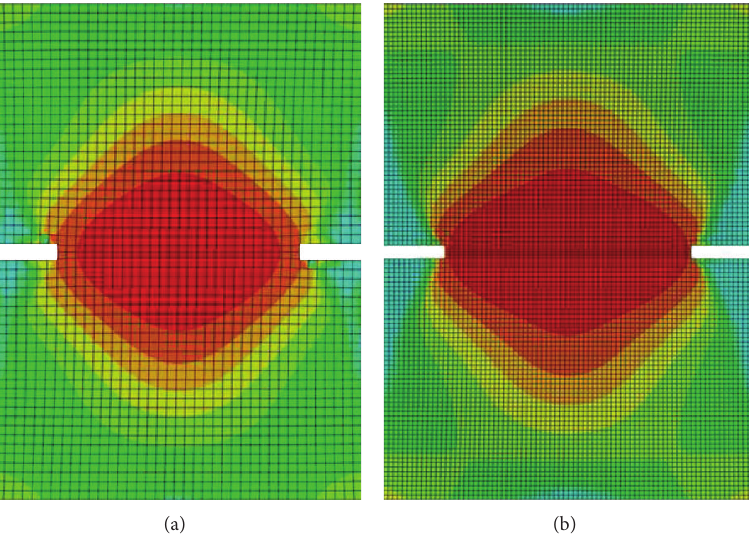
Figure 3: Comparison of the damage distribution of double-notched edge specimen numerical tensile tests using the nonlocal BCJ model, coarse (a) and fine (b) meshes; the value of the length scale used in the simulations is 9mm. The nonlocal damage method has spread the damage to neighboring regions; also, note the similarity between the damage pattern in the two